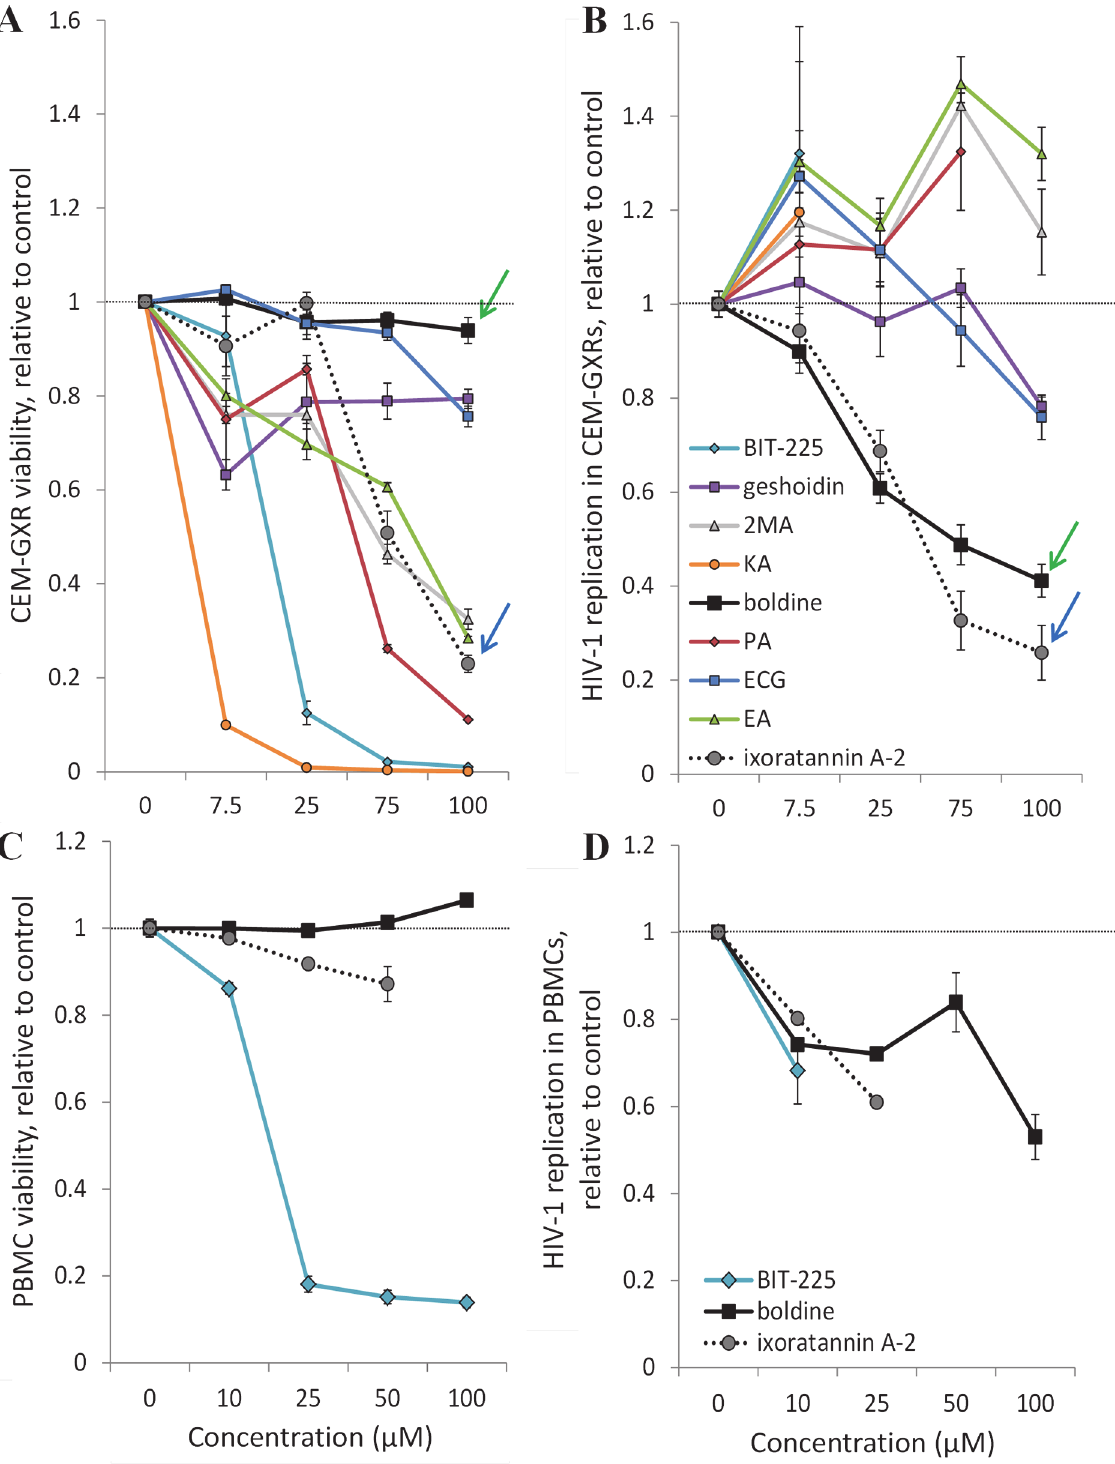
Fig 3. Effects of p-ANAPL compounds on cell viability and in vitro HIV-1 replication. A, CEM-GXR cell viability at Day 4 in the presence of p-ANAPL compounds at defined concentrations. Data are normalized to the percent of viable cells in an HIV-1 NL4-3 -infected culture plus 0.1% DMSO. B, HIV-1 replication in CEM-GXR cells at Day 4 in the presence of compounds. Data are normalized to percent HIV-1 NL4-3 -infected cells plus 0.1% DMSO. Dose- response plots of ixoratannin A-2 and boldine are highlighted with blue and green arrows, respectively. C , PBMC viability at Day 5 in the presence of p-